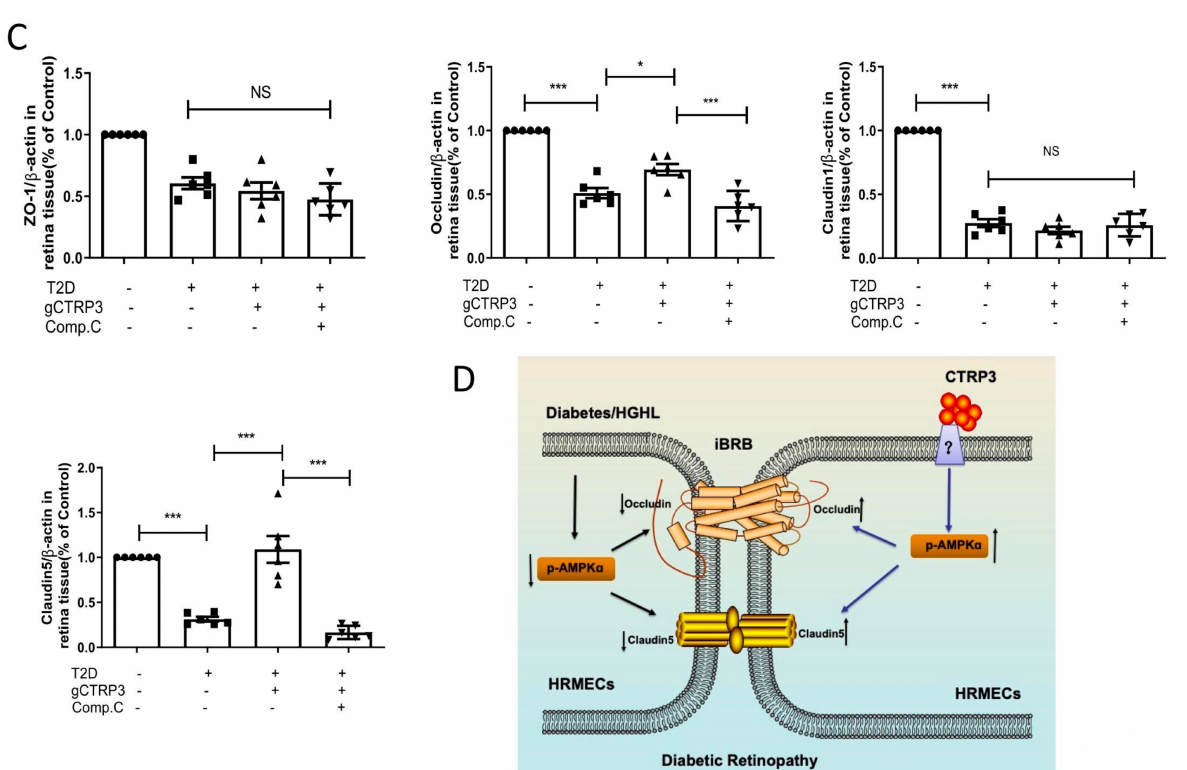
Figure 6. AMPK deficiency blocked CTRP3 upregulated the protein level of Occludin, Claudin-5 in DR. ( A ): Representative Western blots of pAMPK, AMPK, pACC, ACC, Claudin-1, ZO-1, Claudin-5 and Occludin in the retina from Sham and T2D/STZ DR mice with/without gCTRP3 treatment and Compound (C) administration. ( B ), Bar graph for quantification of the expression of pAMPK, AMPK, pACC, and ACC. ( C ), Bar graph for quantification of the expression of Claudin-1, ZO-1, Claudin-5, and Occludin. ( D ), Diagram depicts mechanism responsible for the iBRB protective effects of CTRP3 on diabetic retinopathy. n = 6–8. Bar graph represents analysis from at least 6 independent repeated experiments. Arrow pointing up indicates upregulation; Arrow pointing down indicates downregulation. All data are shown as means ± SD. * p < 0.05, ** p < 0.01. *** p < 0.001; NS,